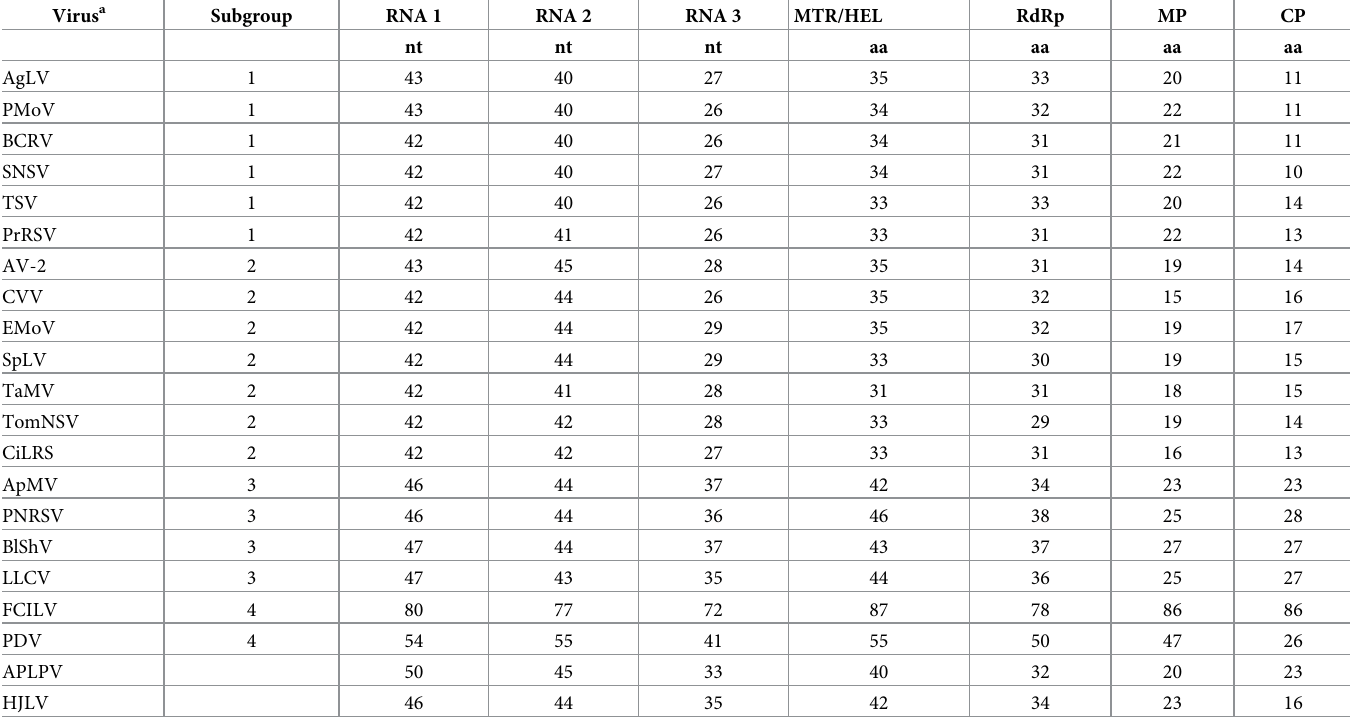
Table 1. Nucleotide and protein sequence identities of PYV to species of the genus Ilarvirus . Virus a